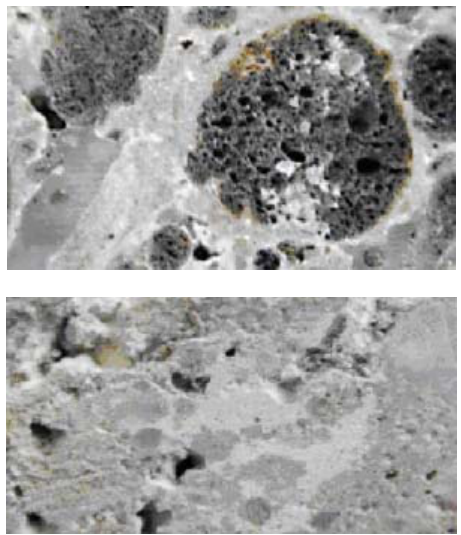
Fig 8. Expanded-clay concrete with thick white edges of secondary minerals, 1 mm thick (ettringite, thaumasite + calcite + gypsum) (a); reinforced concrete with thick loca- tions of secondary minerals, 11 mm thick (ettringite, thaumasite + calcite + gypsum) (b)